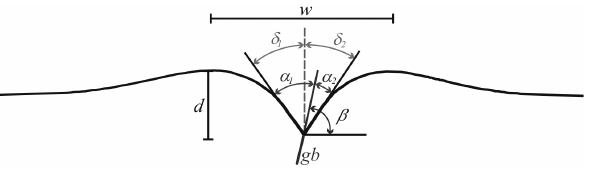
Figure 1. Sketch illustrating the parameters characterizing groove geometry. The distance between humps is termed groove width w , the distance between groove root and a hump is termed groove depth d . The grain boundary (gb) encloses an angle β with the surface of the polycrystal and the two sides of the groove are inclined by angles δ 1 , 2 to the surface’s